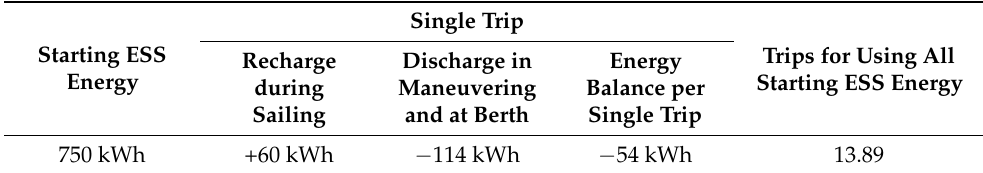
Table 5. Energy balance for case (a).